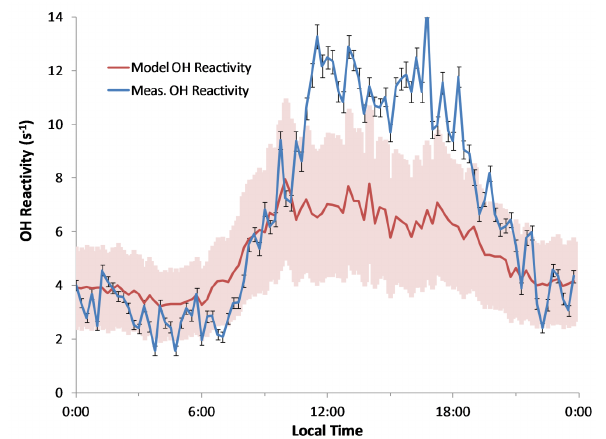
Figure 8: Measured and modeled median total OH reactivity for the period analyzed for CABINEX 2009 Fig. 8. Measured and modeled median total OH reactivity for the (07/26-08/08). Error bars on the measured points are the 2σ uncertainty values (± 3% + 0.14 s -1 , 50 point median). Pink outline is the 2σ uncertainty (+/- 40%) of the modeled OH reactivity. period analyzed for CABINEX 2009 (26 July–8 August). Error bars on the measured points are the 2 σ uncertainty values ( ± 3% + 0.14 s − 1 , 50 point median). Pink outline is the 2 σ uncertainty ( ± 40%) of the modeled OH reactivity.